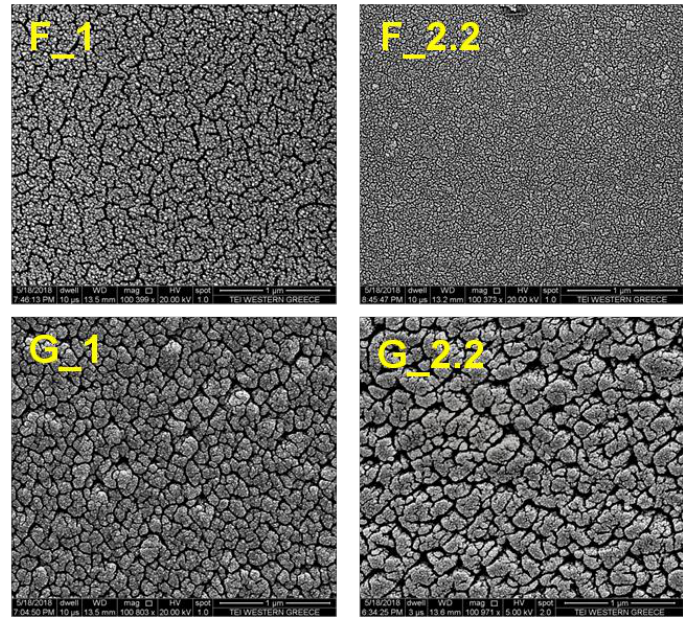
Figure 2. Top-view SEM micrographs of the TiO 2 films. F_1: a = 0°, P = 1 mTorr, F_2.2: a = 0°, P = 2.2 mTorr, G_1: a = 87°, P = 1 mTorr, G_2.2: a = 87°, P = 2.2 mTorr. The scale bar is 1 μ m for all images. mTorr, G_1: a = 87 ◦ , P = 1 mTorr, G_2.2: a = 87 ◦ , P = 2.2 mTorr. The scale bar is 1 µ m for all